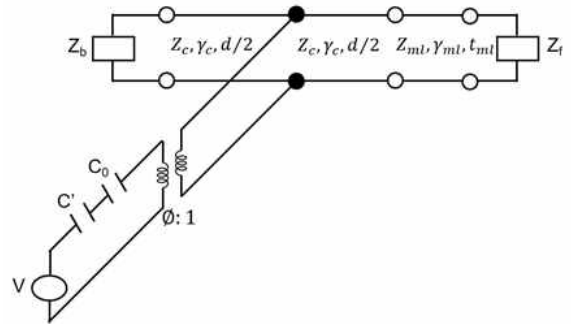
Figure 4. Equivalent circuit model of the proposed sensor.